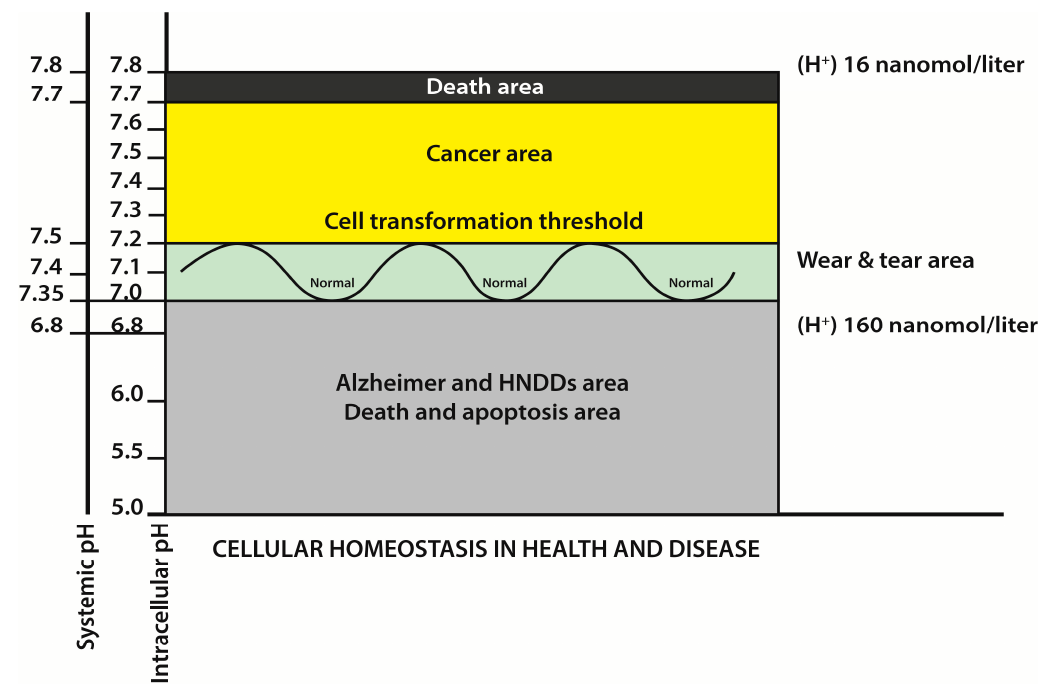
Figure 2. The main aim of the pH-centered treatment is to induce a selective low pHi-mediated apoptosis of all cancer cells. This figure also shows the opposite pH ranges in cancer and in human neurodegenerative diseases (HNNDs). The higher the cellular pH, the lower the hydrogen ion concentrations, and vice versa. For further details, see [13,21].